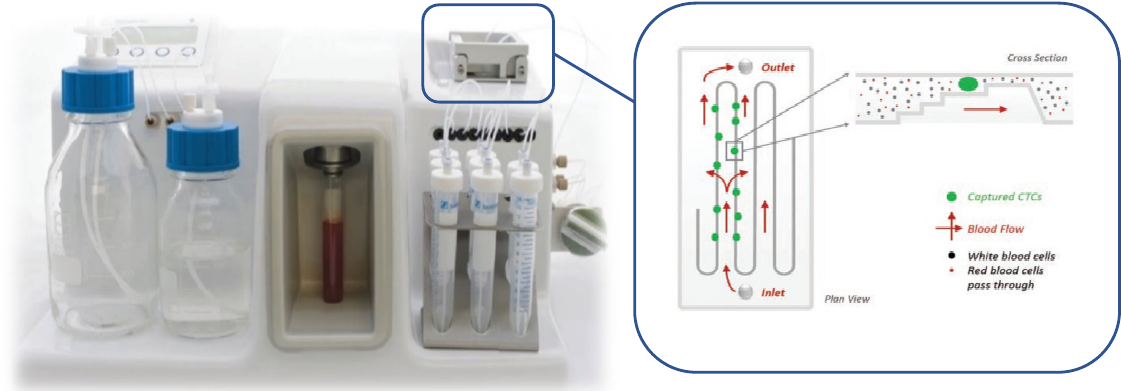
Figure 1. The Parsortix device (blood tube loaded in place) with diagrammatic representation of microfluidic flow and cell sorting within the isolation cassette, demonstrating tiered multi-channel design (pictures reproduced with permission of Angle Plc).